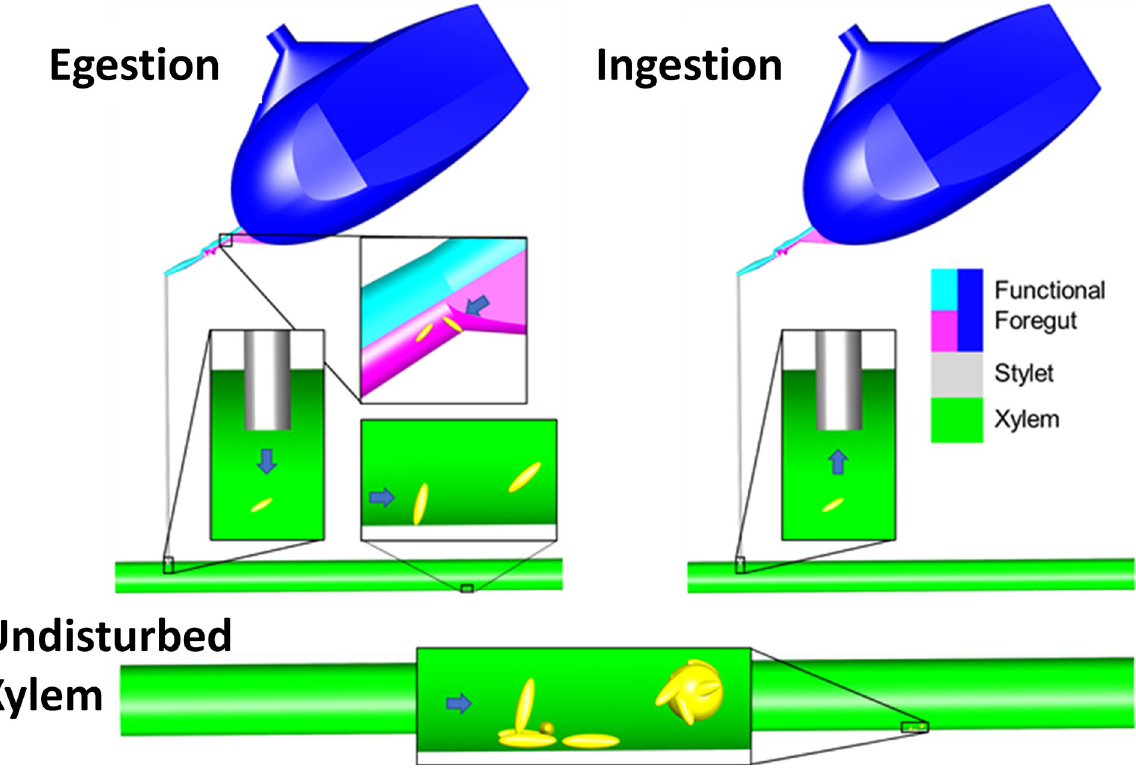
Fig 5. Inferred model of detachment-based transmission and virulence. The model describes the effects of xylem sap flow on surface-attached bacteria during ‘Egestion,’ ‘Ingestion,’ and in ‘Undisturbed Xylem.’ The cibarial diaphragm is probably not fully extended, as shown here, for ingestion, but is likely for very powerful egestion. See text for detailed description. Stylet = stylet bundle, or all four stylets held together to form a